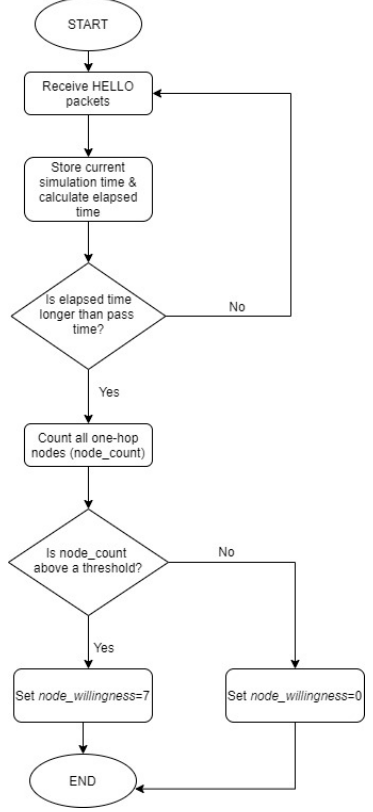
Figure 2. Node willingness based on the node count.